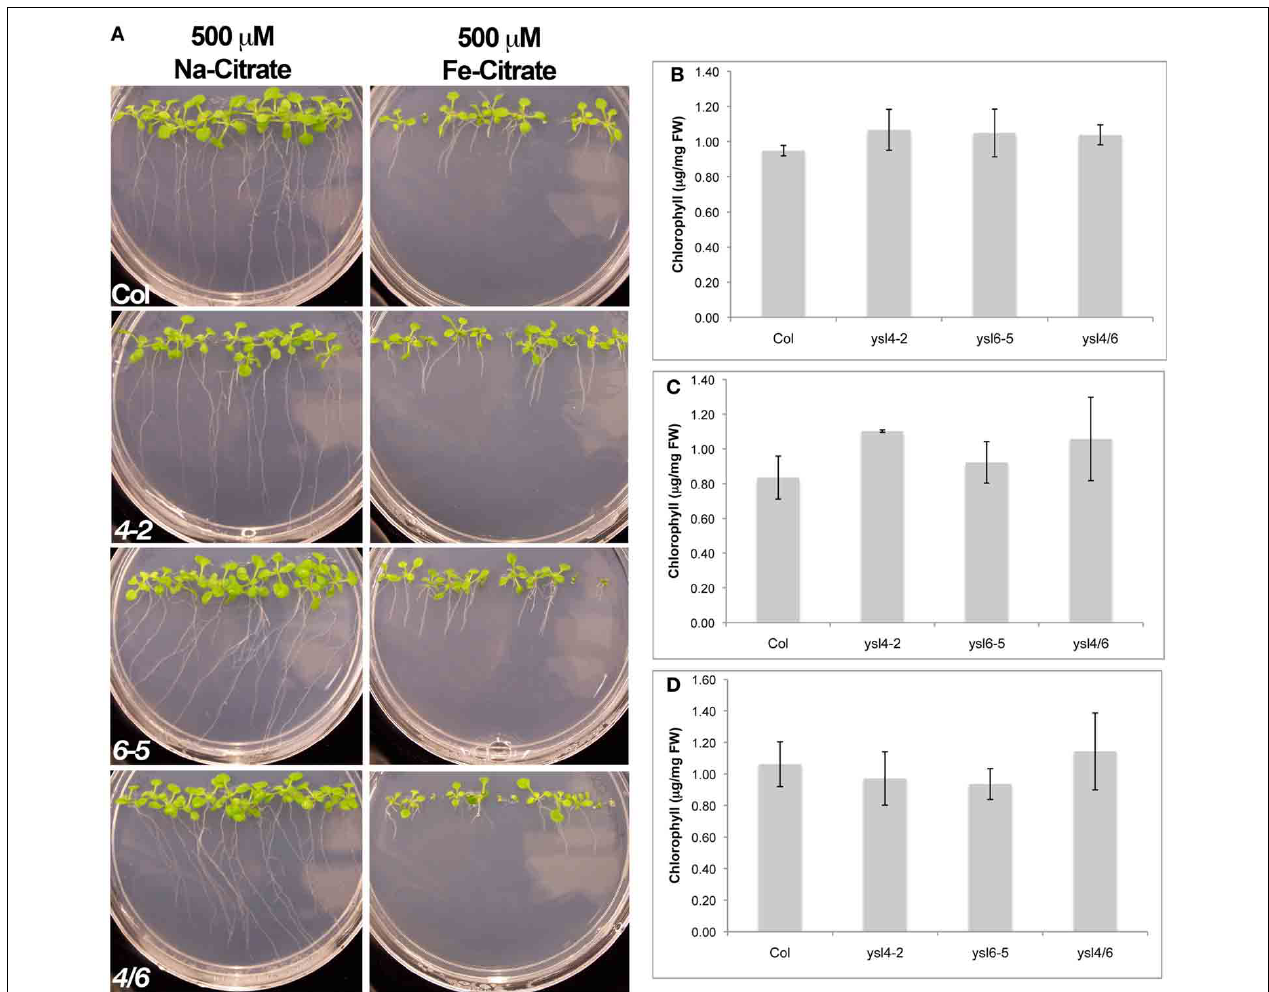
FIGURE 9 | Response of Col-0, ysl4-2, ysl6-5 and ysl4ysl6 to Fe-citrate excess. (A) Plants were grown vertically for two weekson mediumcontaining either 500mM Na-Citrate or 500mM FeCitrate prior to photographing. (B) Plants were grown for 2 weeks on regular MS medium (no additives, pH 5.7) before measuring chlorophyll content. (C) Plants were grown for 2 weeks on